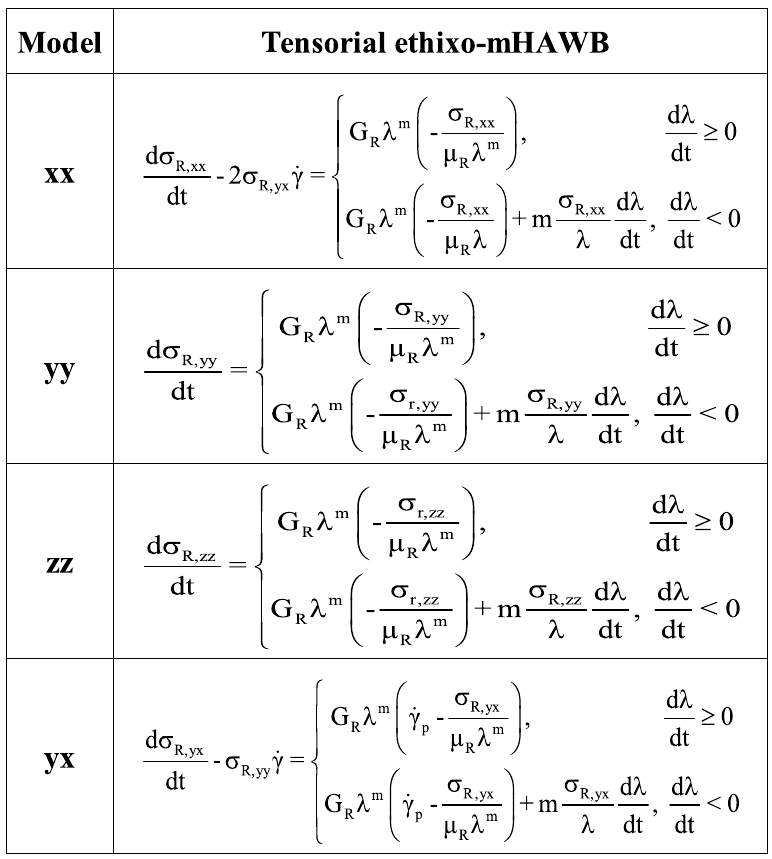
Table 3. t-ethixo-mHAWB model equations (for the VE, rouleaux) 24,41 .